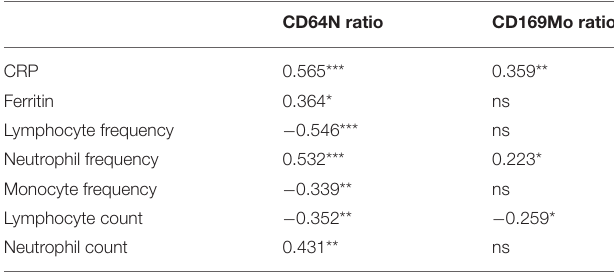
TABLE 2 | Correlation coefficients and p -values between biochemical and hematological parameters and biomarkers of acute